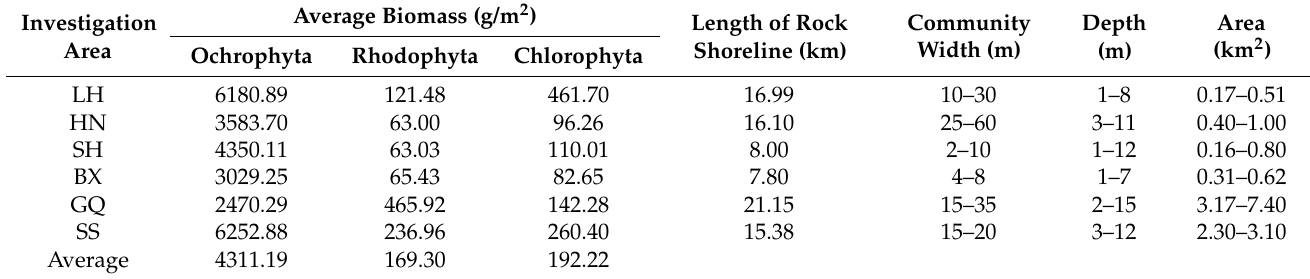
Table 2. Distribution characteristics of